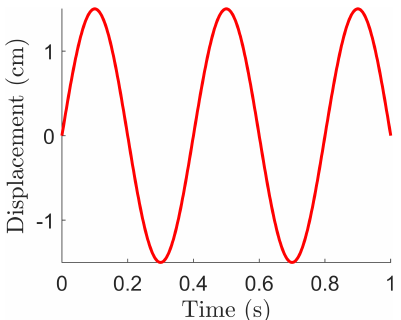
Figure 8. Input displacement used to identify parameters for the magnetorheological damper system.